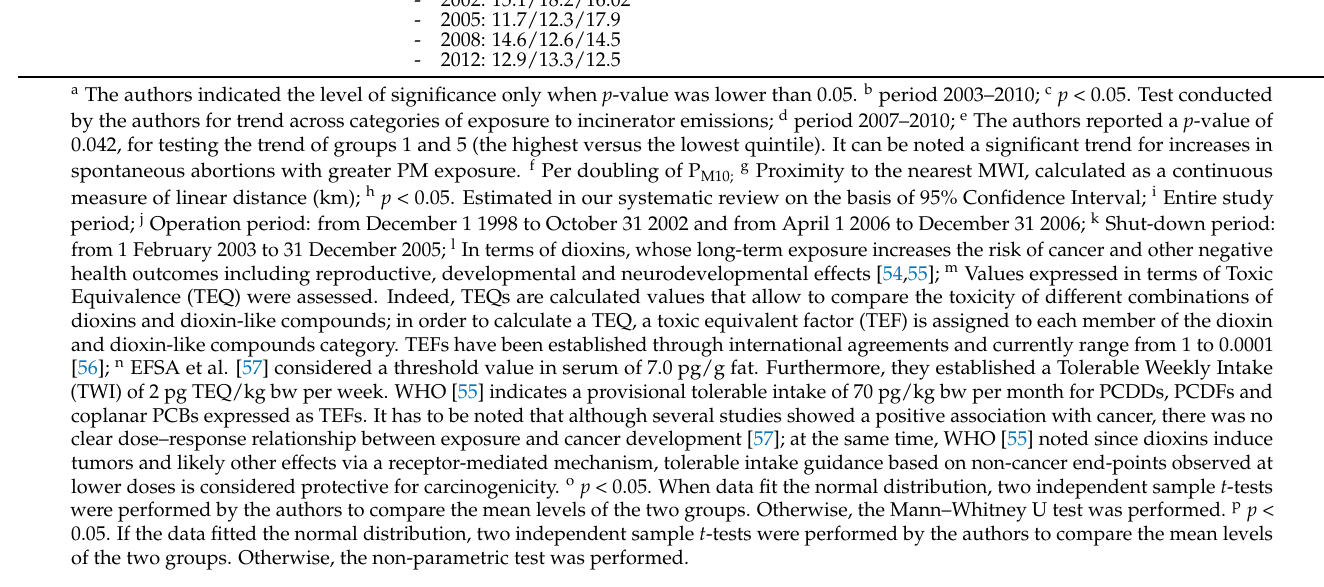
Table 5. Dumpsites and open burning—methodology characterizing each